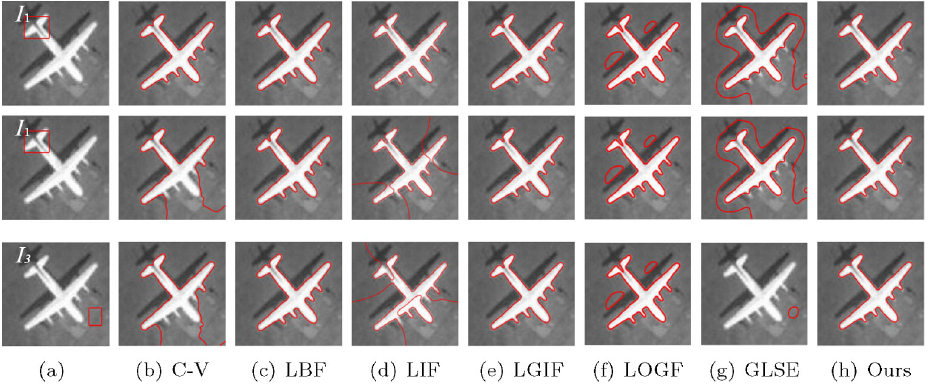
Fig 8. Comparisons for an airplane image with varying initial